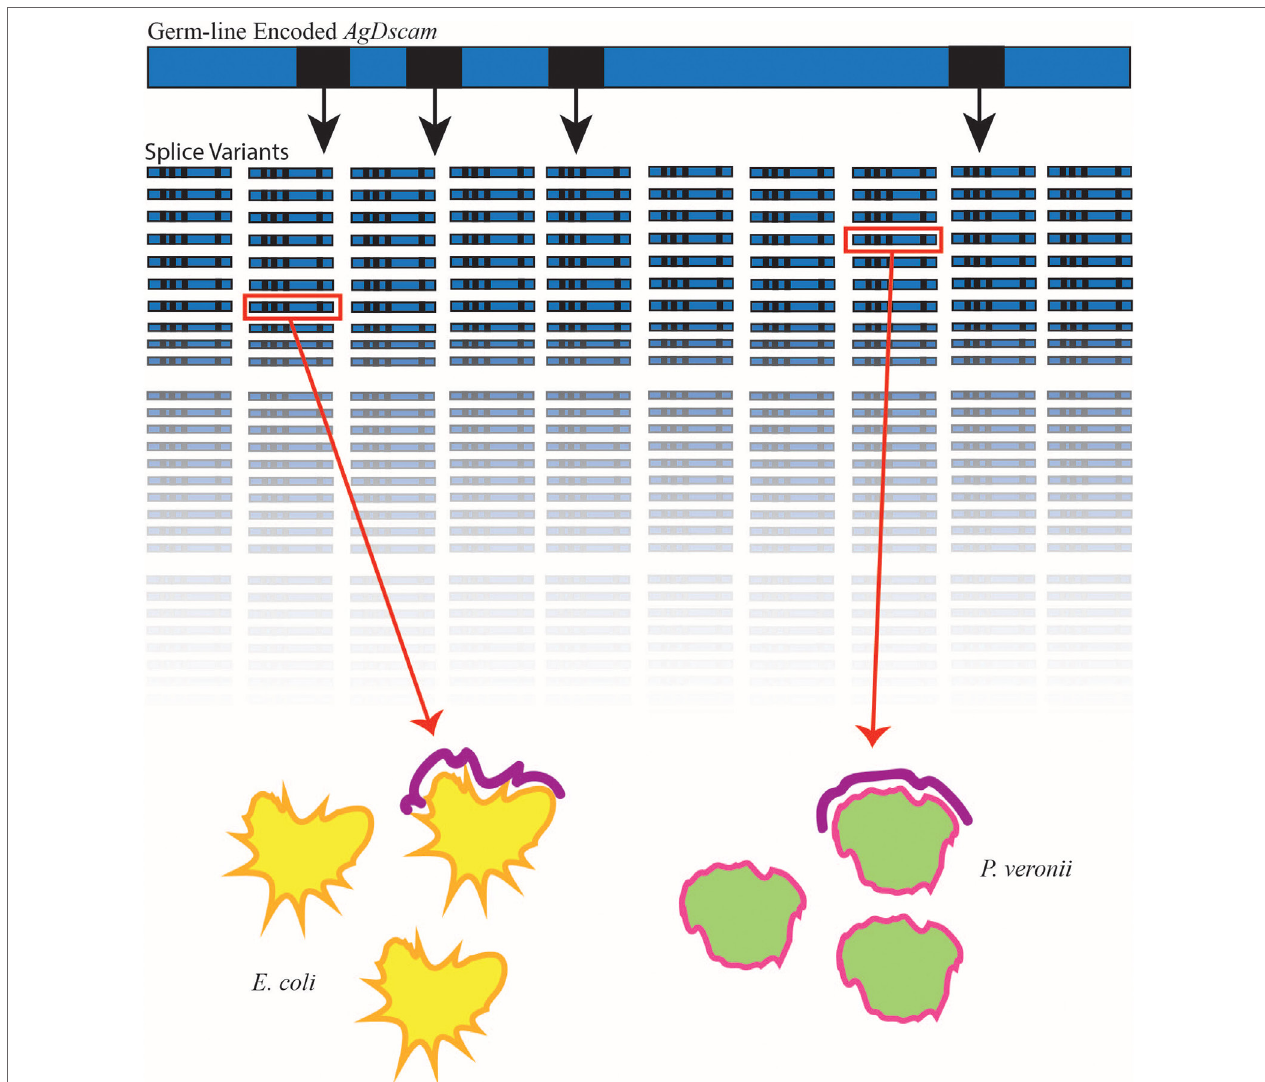
FiGURe 2 | Anopheles gambiae Down syndrome cell adhesion molecule (AgDscam), a member of the ig superfamily, generates semi-specific splice variants in response to various immune elicitors . In A. gambiae , immune elicitors such as Escherichia coli (yellow) and P. veronii (green) have been shown to lead to the generation of pathogen-specific splice variants (purple) of the germ line-encoded AgDscam. AgDscam (blue bar) contains four exons (black squares), which exhibit alternative splicing, capable of producing 31,920 different isoforms (represented in rows). When mosquitoes are exposed to various bacteria, the repertoire of AgDscam splice variants not only differ but also contain a majority of variants capable of binding to the bacteria (inside red square) to which the insect is